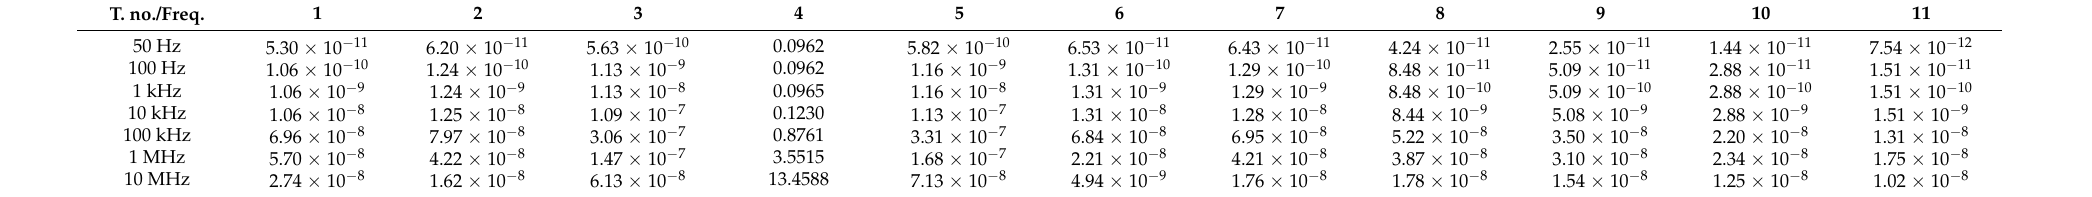
Table A13. Self and mutual resistances of turn 4 (in Ω ) resulting from FEM simulations. T. no./Freq.